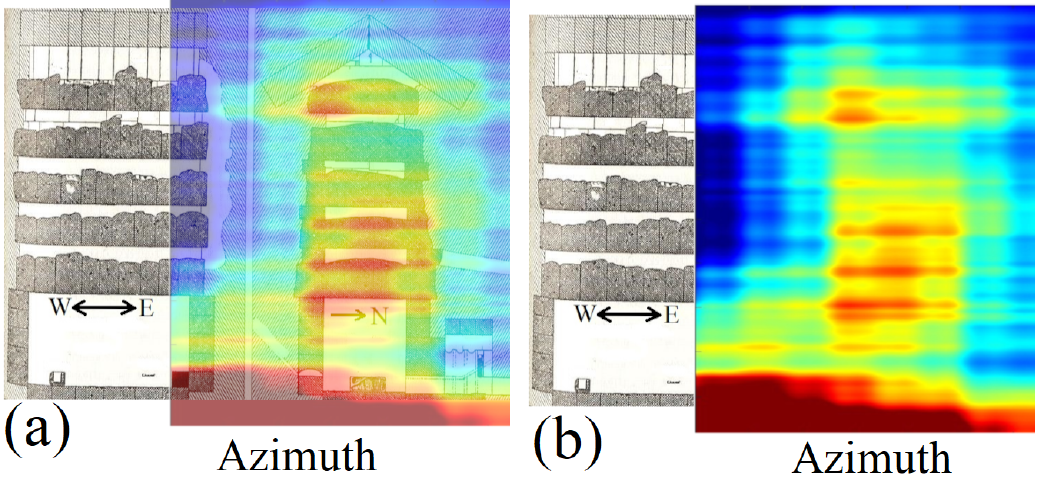
Figure 28. Schematic representation of the Zed and the King chamber. ( a ): Schematic representation of the Zed and the King chamber with partially-overlapped tomographic result. ( b ): Schematic representation of the Zed and the King chamber with totally-overlapped tomographic